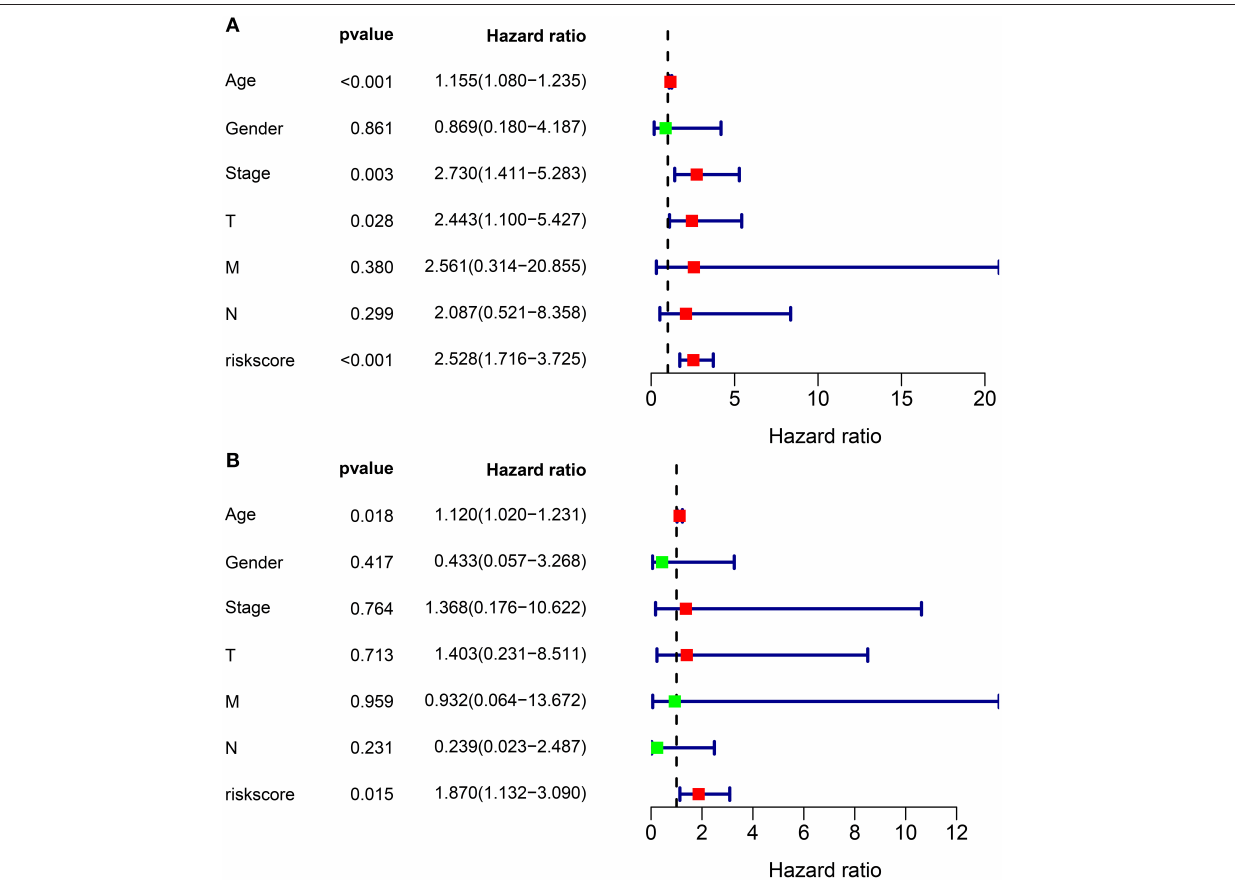
FIGURE 2 | The independency of the ferroptosis-related eight-gene model for predicting the clinical outcomes for thyroid cancer. (A) Univariate cox regression analysis for assessment of the prognostic values of different clinicopathological characteristics (age, gender, stage, T, N, M) and the risk score. (B) Evaluation of the independency of the risk score and other factors for predicting the prognosis of thyroid cancer using multivariate cox regression analysis.